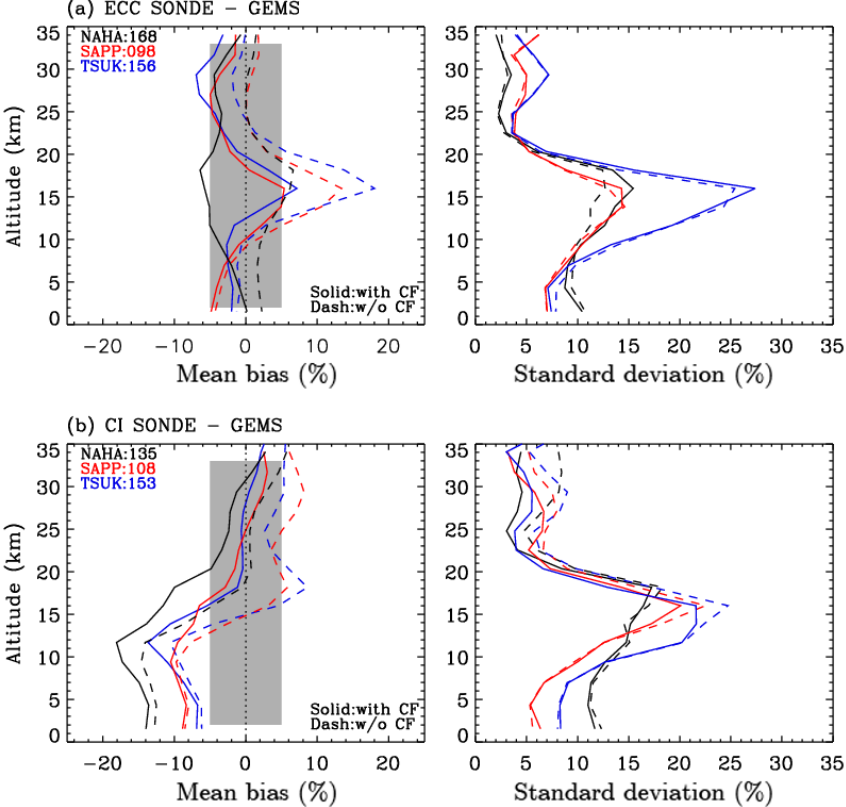
Figure 4. Effects of applying a correction factor (CF) to (a) ECC and (b) CI ozonesonde measurements, respectively, on comparisons with simulated GEMS ozone profile retrievals. Solid and dashed lines represent the comparisons with and without applying a CF, respectively, at each Japanese station. The number of data point is included in the